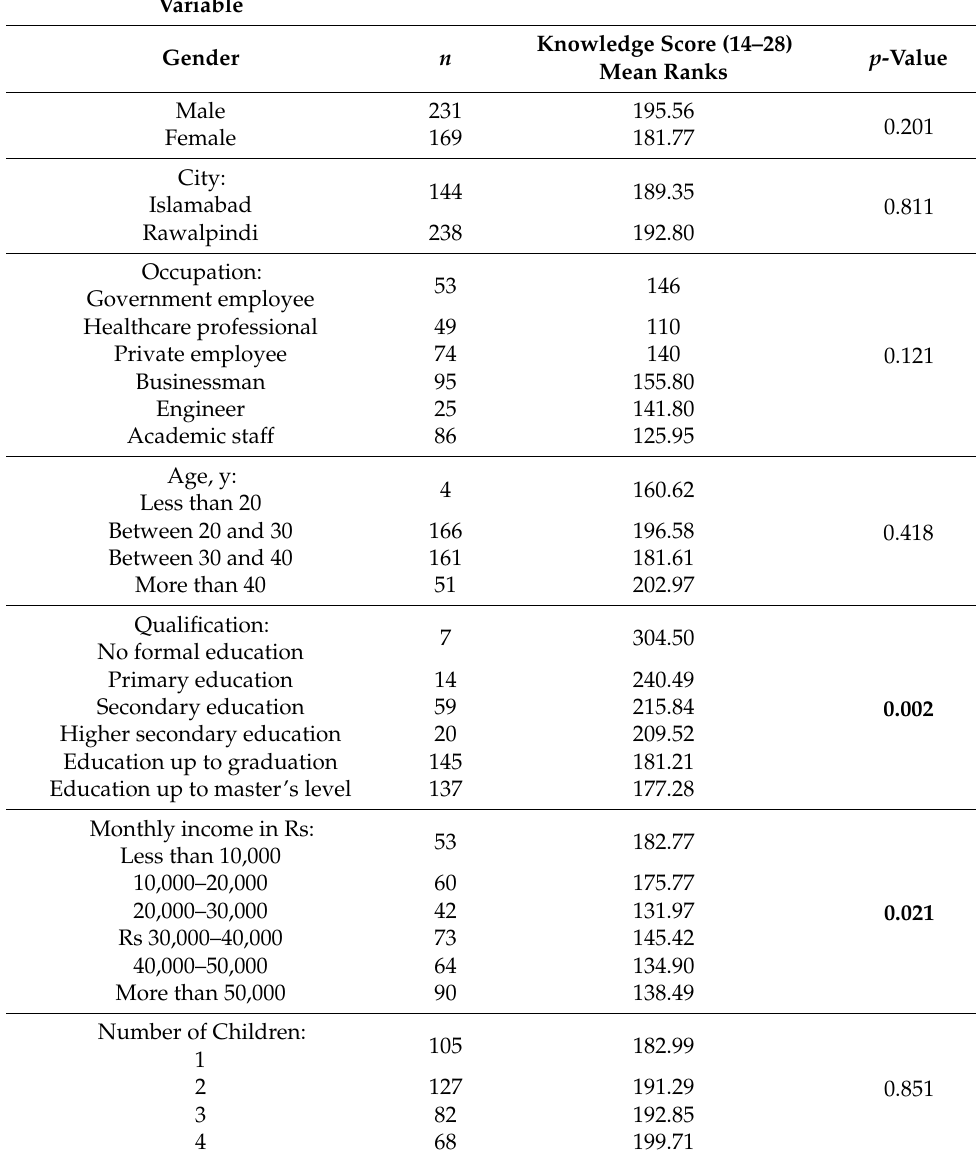
Table 8. Comparison of parents’ knowledge scores about the immunization of their children under two years of age by demographic